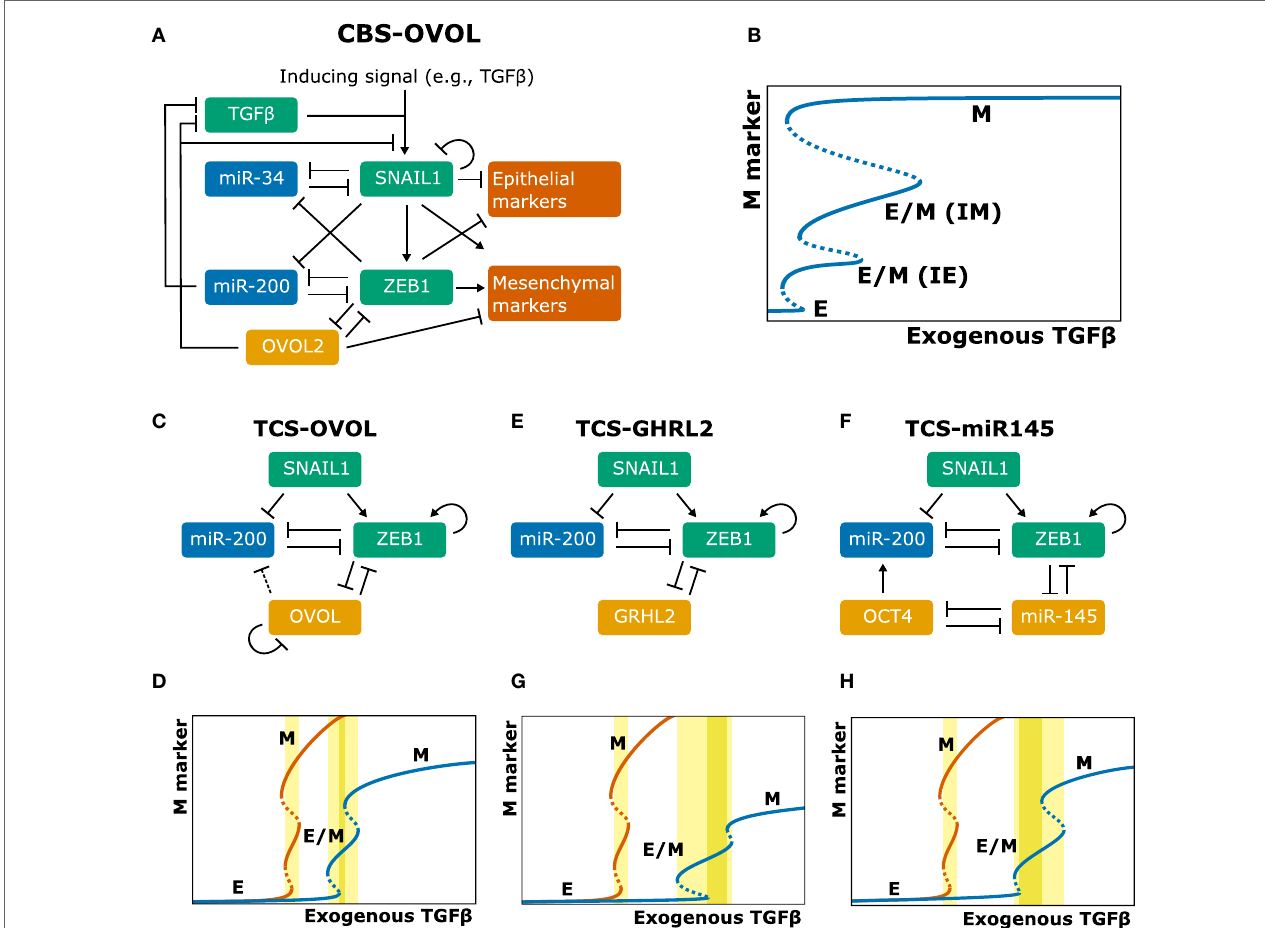
FiGURe 2 | Extensions of the core regulatory models and their behavior. (A–H) Model schemes (A,C,e,F) and corresponding bifurcation diagrams (B,D,G,H) of various extensions of the ternary chimera switch (TCS) and cascading bistable switches (CBS) models: the CBS-OVOL model (A,B) , the TCS-OVOL model [ (C,D) ; dashed line in panel (C) indicates inhibition of miR-200 by OVOL which occurs in prostate cancer but not in breast cancer], the TCS-Grainyhead-like transcription factor 2 model (e,G) , and the TCS-miR145 model (F,H) . Bifurcation diagrams of the unmodified TCS model are shown in orange and of modified TCS models in blue. TGF β ranges are highlighted for which there exists a stable hybrid E/M state (light yellow) and for which this is the only stable state (dark yellow). Note that in the extensions of the TCS model, this model is first simplified by considering SNAIL as input, which can be done because the tristability in that model is fully determined by the miR-200/ZEB module [ (A,B) based on Ref. (39); (C–H) based on Ref. (43,